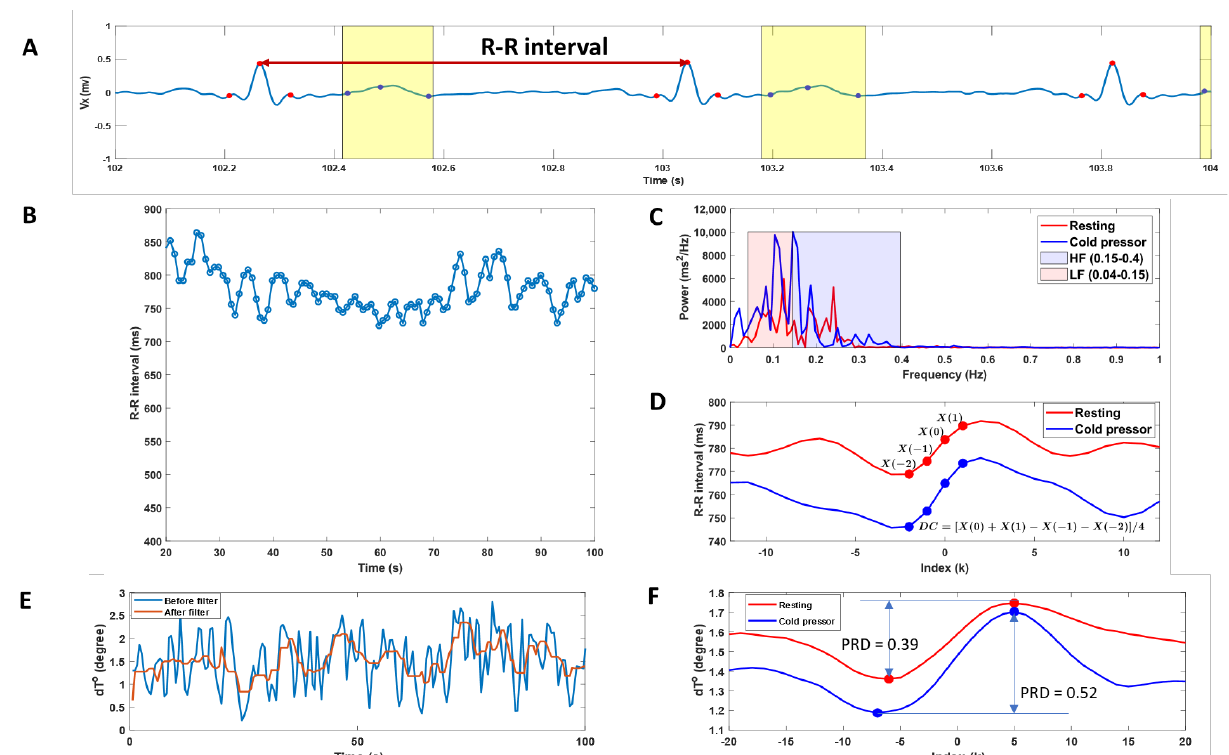
Figure 3. A single representative example of the calculated heart rate variability (HRV), deceleration capacity of heart rate (DC), and periodic repolarization dynamics (PRD). ( A ): Vx component of the ECG signals with detected QRS complexes (red scatters) and T-waves (blue scatters and the yellow box). ( B ): Heartbeat (RR) intervals change during the experimental period. ( C ): Spectral analysis in the frequency domain of the RR interval data during resting and cold pressor test. The low-frequency power (0.04–0.15 Hz) and high-frequency power (0.15–0.40 Hz) were assessed by integrating the power spectral density curves. ( D ): Deceleration-related phase-rectified signal averaging curves of the heartbeat (RR) intervals during resting and cold pressor tests. The DC of heart rate was calculated from phase-rectified signal averaging curves of the RR intervals at index points of 0, 1, −1, and −2. ( E ): dT° angle change over time before and after low-pass filtering. ( F ): Phase-rectified signal averaging curves of the dT° angle during resting and cold pressor tests. The magnitude of the oscillations is quantified using PRD, which is a measure of the amplitude of the central part of the phase-rectified signal averaging curves.